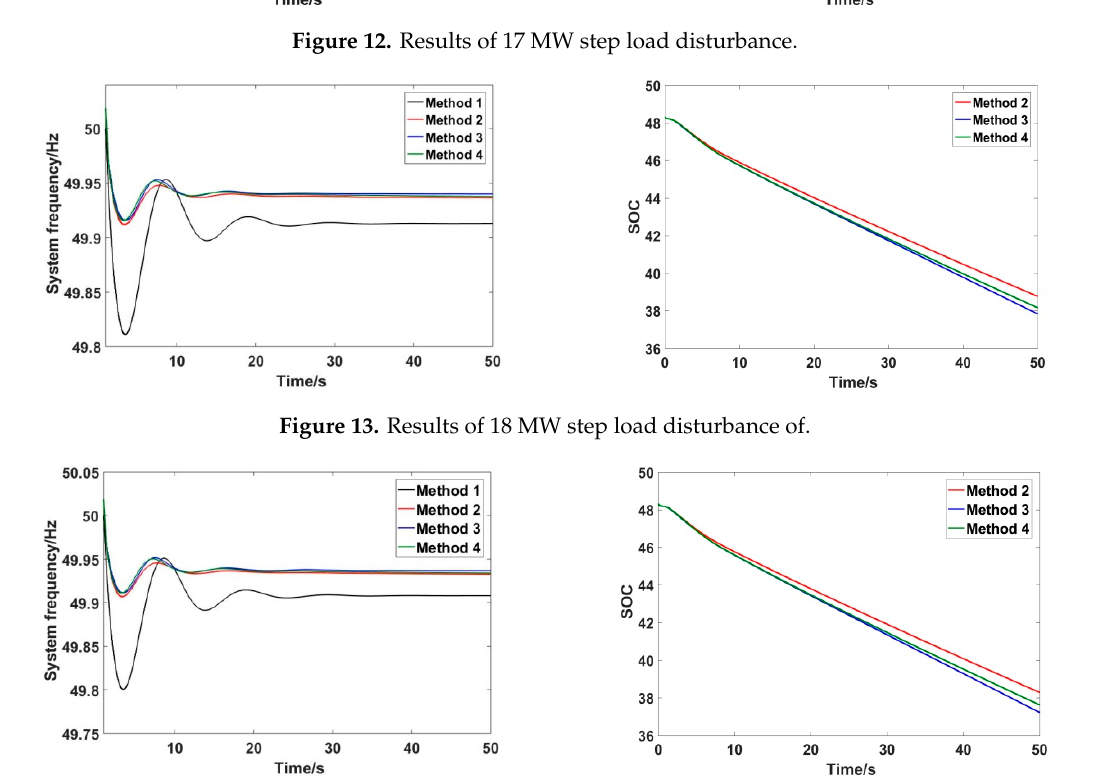
Figure 14. Results of 19 MW step load disturbance